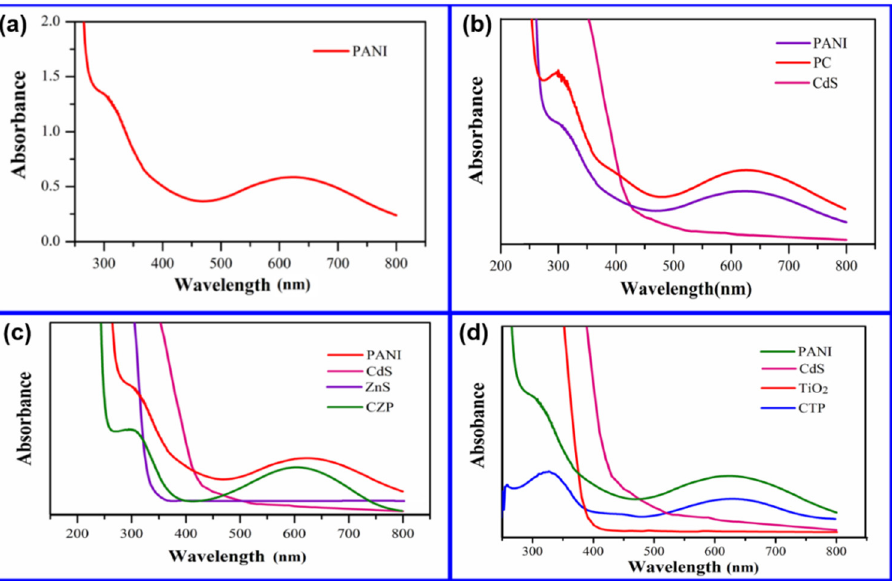
Figure 8. ( a ) UV-visible spectra of PANI in the range 200 to 800 nm ( b ) UV-visible spectra of PC in comparison to bulk CdS and synthesized PANI. ( c ) UV-visible spectra of CZP in comparison to bulk CdS and ZnS and synthesized PANI. ( d ) UV-visible spectra of CTP in comparison to synthesized PANI, bulk CdS and ZnS.